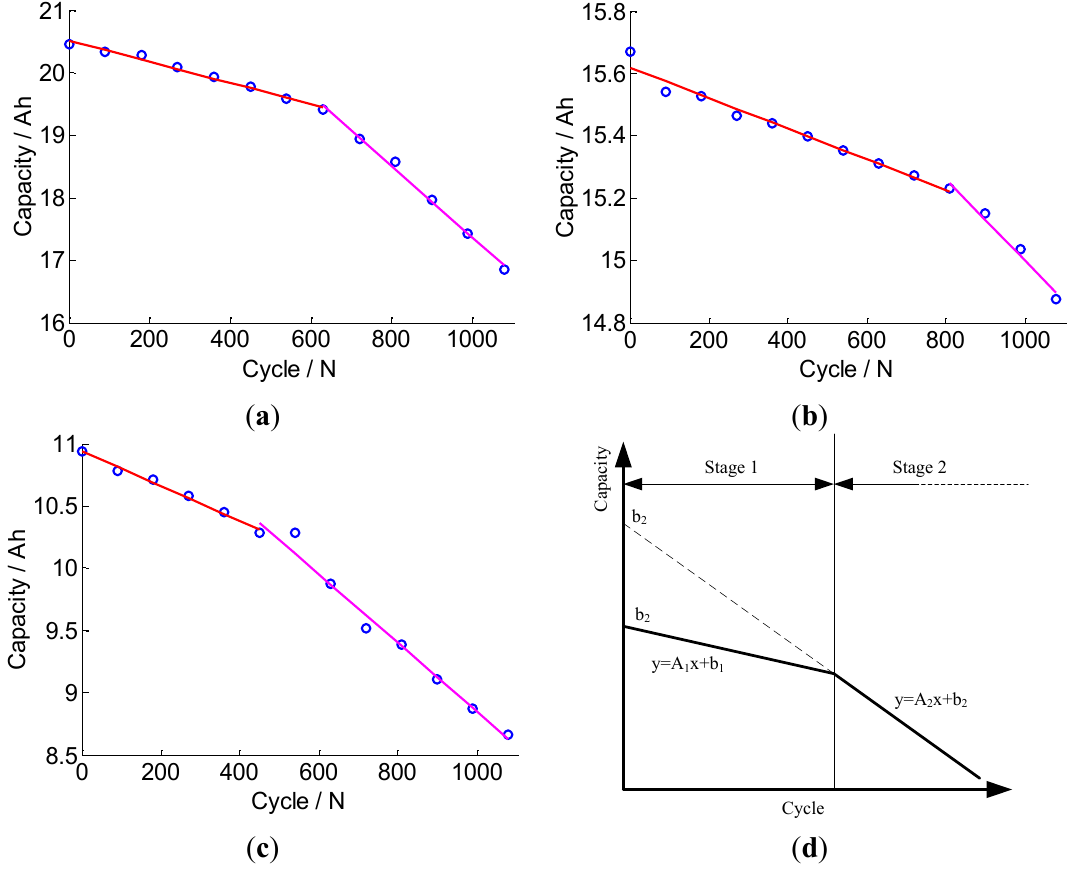
Figure 2. The capacity fade results of the three cells: ( a ) capacity retention of Cell A; ( b ) capacity retention of Cell B; ( c ) capacity retention of Cell C; and ( d ) schematic of the two-stage capacity fade profile with cycle